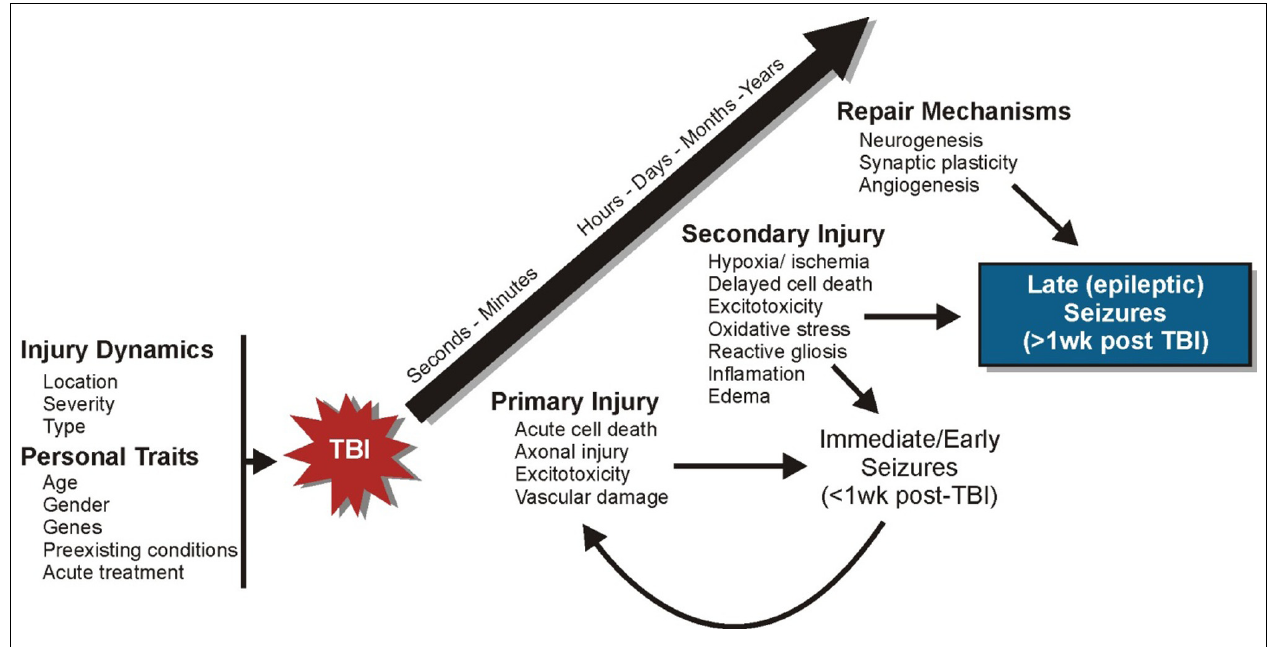
FIGURE 1 | Progression of cellular events followingTBI. A series of cellular and molecular events occur followingTBI that involve three temporally overlapping responses in the brain: primary and secondary injuries and “self-repair”